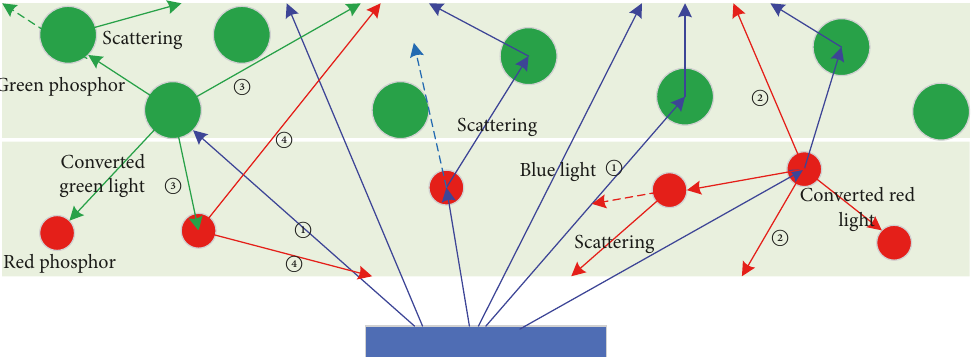
Figure 11: Schematic diagram of light propagating direction in phosphor